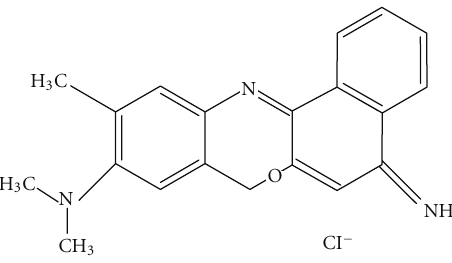
Figure 1: Molecular structure of cresyl violet.